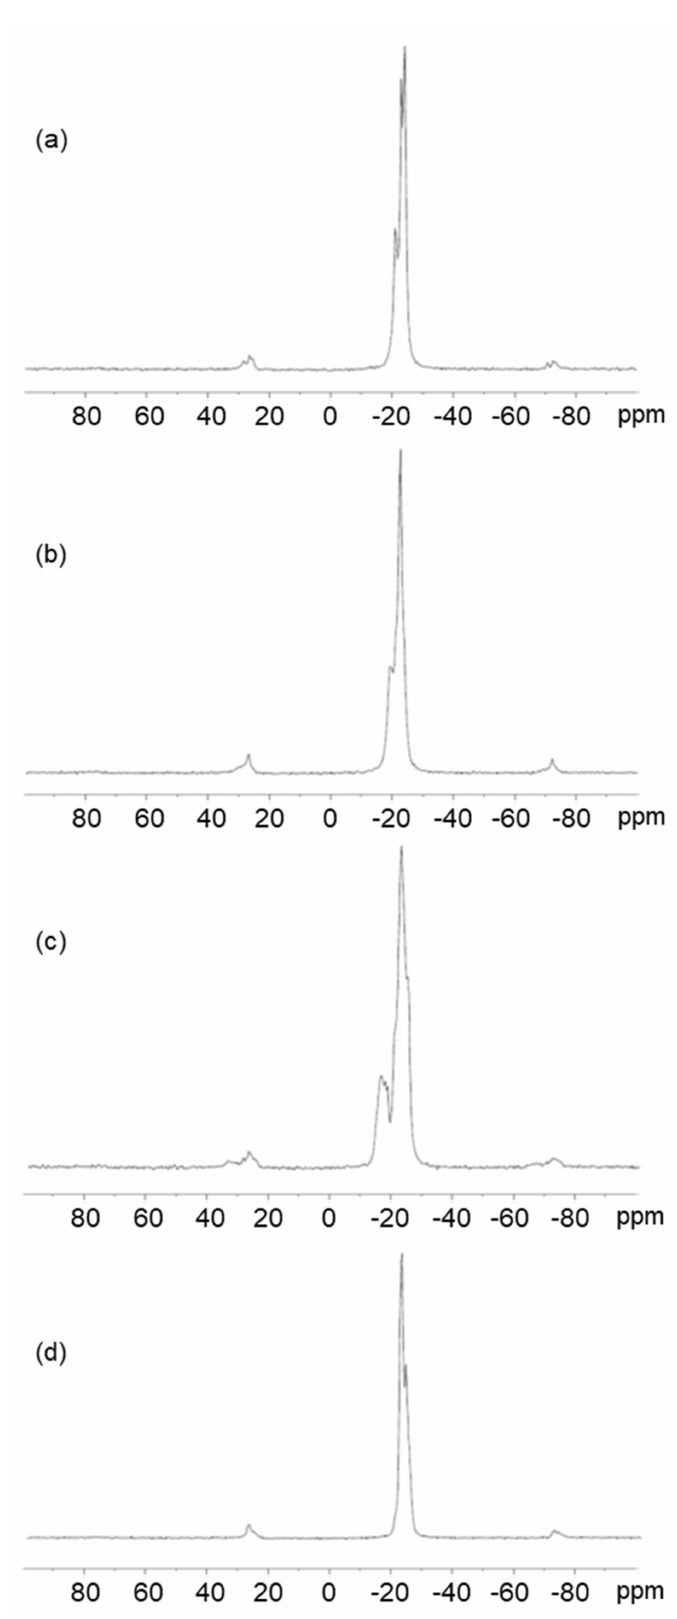
Figure 2. 31 P NMR spectra of ( a ) α -ZrP · 0.58DBU, ( b ) α -ZrP · 0.44DBU, ( c ) α -ZrP · 0.22DBU, and ( d ) α -ZrP ·